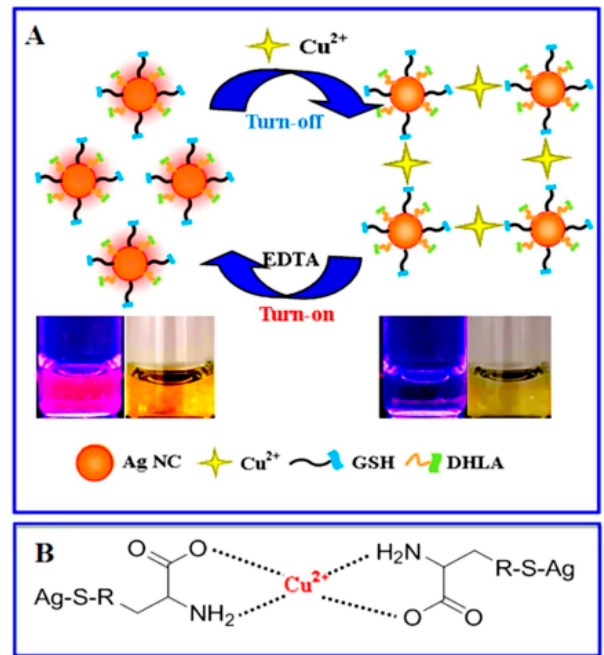
Figure 7. Schematic illustration of ( A ) the reversible fluorimetric and colorimetric detection mechanism and procedure of L-glutathione (GSH)-passivated Ag NCs toward the fluorimetric and colorimetric assays for Cu 2+ ions (insert: the photographs of corresponding products), and ( B ) the chelating interaction between Cu 2+ ions and GSH of GSH-passivated Ag NCs (Copyright Ref [89], Nature